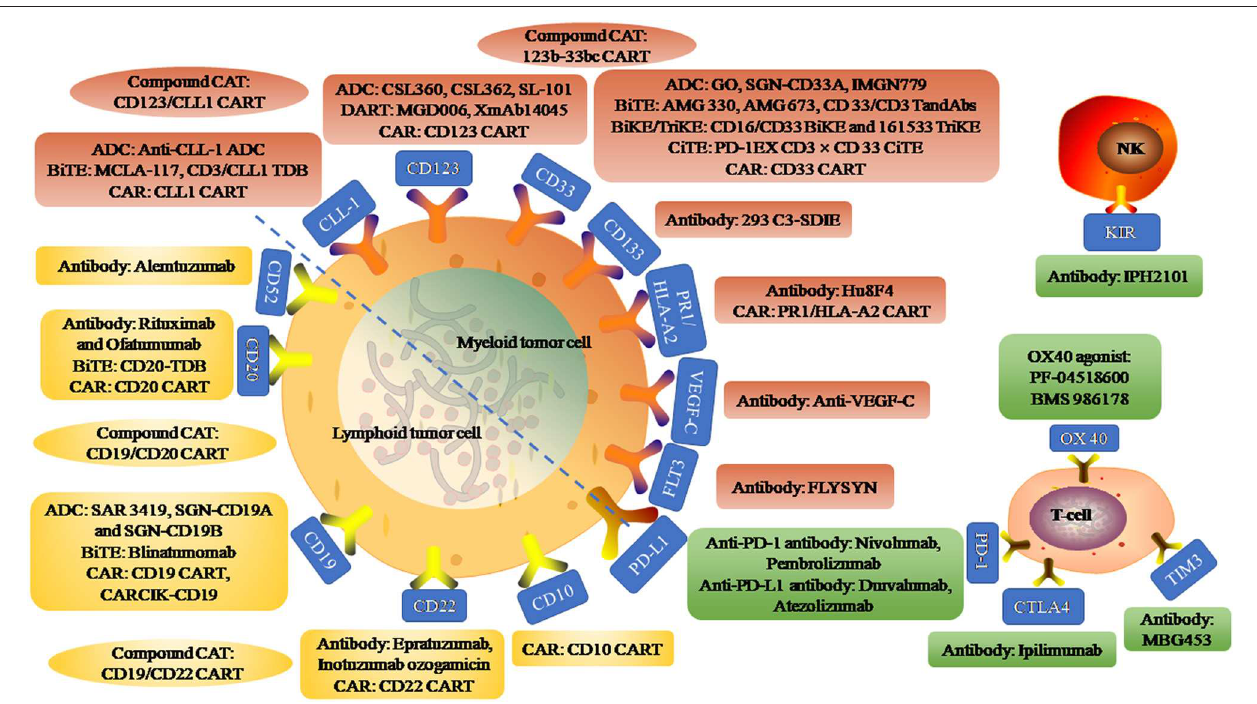
FIGURE 1 | An overview of immunotherapy targets for acute myeloid leukemia and acute lymphoblastic leukemia. Myeloid tumor cell surface antigen targets include CLL-1, CD123, CD33, CD133, PR1/HLA-A2, VEGF-C, and FLT3. Anti-CLL-1 ADC, an antibody-drug conjugate (ADC) targeting CLL-1 that binds to pyrrole diazepine dimer. MCLA-117 is a full-length human IgG1 Bi-Specific T-cell Engagers (BiTE) targeting CLL-1 and CD3. CD3/CLL1 TDB, a CD3 T-cell-dependent bispecific (TDB) full-length humanized IgG1 antibody targeting CLL1. CSL360 and CSL362 are recombinant chimeric antibody targeting CD123 and fully humanized anti-CD123 antibody, respectively. SL-101, an CD123 ADC fused to Pseudomonas exotoxin A. MGD006 is a bispecific CD3xCD123 dual-affinity re-targeting (DART) molecule. XmAb14045, a structured anti-CD123T cell recruitment antibody. GO, SGN-CD33A, and IMGN779 are CD33 ADC binding to N-acetylgamma-erythromycin, pyrrolidone dimer and DNA alkylation activity, respectively. AMG 330 is a CD33/CD3 BiTE and AMG 673 is the second CD33/CD3 BiTE. CD33/CD3 TandAbs is a directional tandem tetravalent bispecific antibody. CD16/CD33 BiKE is a Bi-Specific Killer Engagers (BiKE) targeting CD16 and CD33, and 161533 TriKE is a Tri-Specific Killer Engagers (TiKE) including a modified IL-15 crosslinking agent between CD 16 and CD 33 single-chain Fv fragments. PD-1EX with CD3xCD33 BiTE, fused the PD-1 extracellular domain (PD-1EX) with CD3xCD 33 BiTE. Hu8F4, a T-cell receptor-like monoclonal antibody targeting PR1/HLA-A2. PR1/HLA-A2 CART, PR1/HLA-A2-specific CART (h8F4-CAR-T cells), containing the scFv of h8F4 fused to CD3 zeta chain through the co-stimulatory domain of CD28. Anti-VEGF-C, an antibody targeting vascular endothelial growth factor C to reduce expansion and enhance differentiation. FLYSYN and 293 C3-SDIE are antibodies targeting FLT3 and CD133. Compound CART include 123b-33bc CART simultaneously targeting CD123 and CD33, and CD123/CLL1 CART simultaneously targeting CD123 and CLL1. Lymphoid tumor cell surface antigen targets include CD52, CD20, CD19, CD22, CD10. Rituximab and Ofatumumab are antibodies targeting CD20. CD20-TDB, is a CD3 TDB full-length humanized immunoglobulin G1 molecule targeting CD20. SAR 3419, SGN-CD19A, and SGN-CD19B are CD 19 ADC that binds to Maytansin, Monoinositol F and Pyrrolidine diazepine, respectively. Blinatumomab, a BiTE with dual specificity for CD19 and CD3. CARCIK-CD19, a cytokine-induced killer (CIK) cells transfected with the transposon CD19CAR. Epratuzumab and Inotuzumab ozogamicin are unconjugated human antibody targeting CD22 and humanized anti-CD 22 ADC, respectively. Alemtuzumab, an anti-CD52 antibody. Compound CART include CD19/CD20 CART simultaneously targeting CD19 and CD20, and CD19/CD22 CART simultaneously targeting CD19 and CD22. Immune targets include inhibitory receptors programmed cell death protein 1 (PD1), cytotoxic T-lymphocyte antigen 4 (CTLA4), T-cell immunoglobulin and mucin-domain containing-3 (TIM3), and stimulatory receptors OX40 on T-cell subsets and their ligands (PD-L1, PD-L2, B7, and OX40L) on AML blasts. IPH2101, anti antibody targeting KIR on NK cell